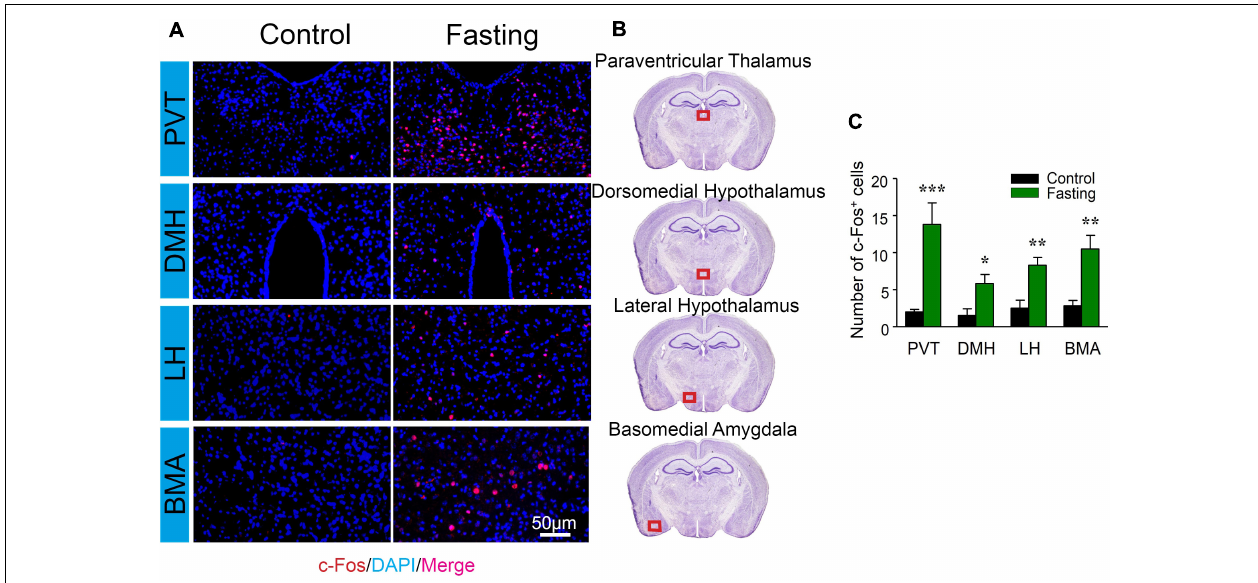
FIGURE 6 | Acute fasting increases the c-Fos expression in different sub-cortical areas. (A) Representative photomicrographs of c-Fos immunostaining in the sub-region of the cortex including paraventricular thalamus (PVT), dorsomedial hypothalamus (DMH), lateral hypothalamus (LH), and basal amygdala (BMA). There were a higher number of c-Fos + cells in the fasting group (right panel) in comparison with the control group (left panel). Scale bars represent 50 µ m. (B) Schematic illustration of the regions of interest. The red box (500 µ m × 140 µ m) indicates the captured and analyzed sub-region of the cortex. (C) The number of c-Fos + cells in different sub-cortical areas. Note that the number of c-Fos + cells was significantly elevated following 9-h fasting as compared to the control condition. Data are shown as mean ± SEM (Student’s t -test; ∗ p < 0.05; ∗∗ p < 0.01; ∗∗∗ p < 0.001; n = 4–6